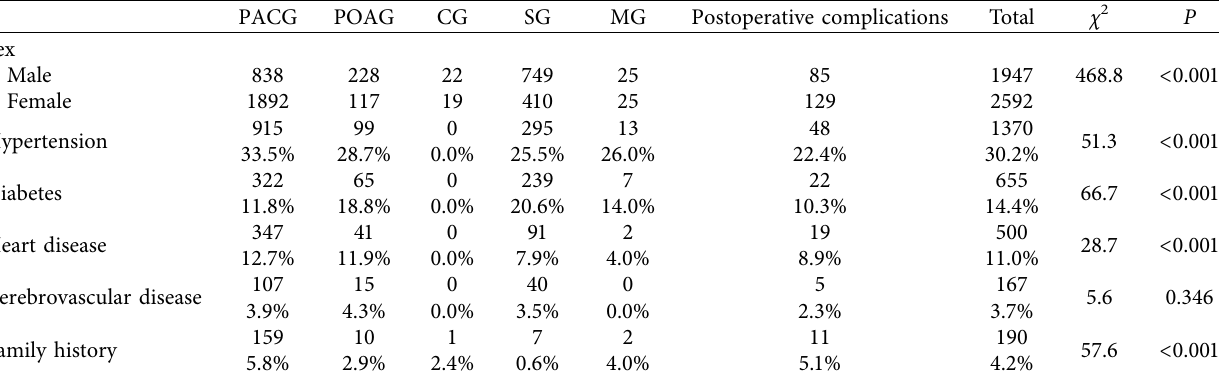
Table 2: Univariate analysis of different factors in different glaucoma